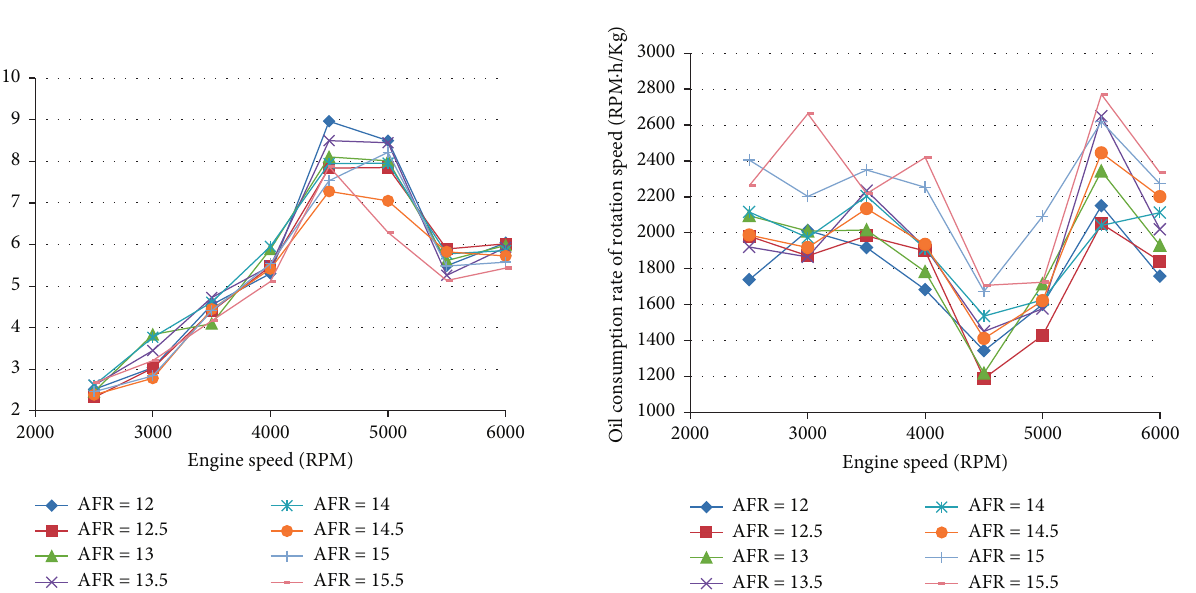
Figure 15: Oil consumption rate of rotation